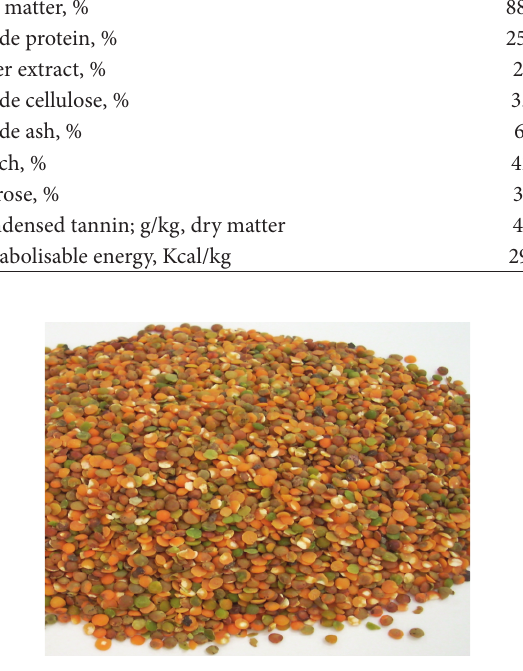
Figure 1: Lentil byproduct used in the